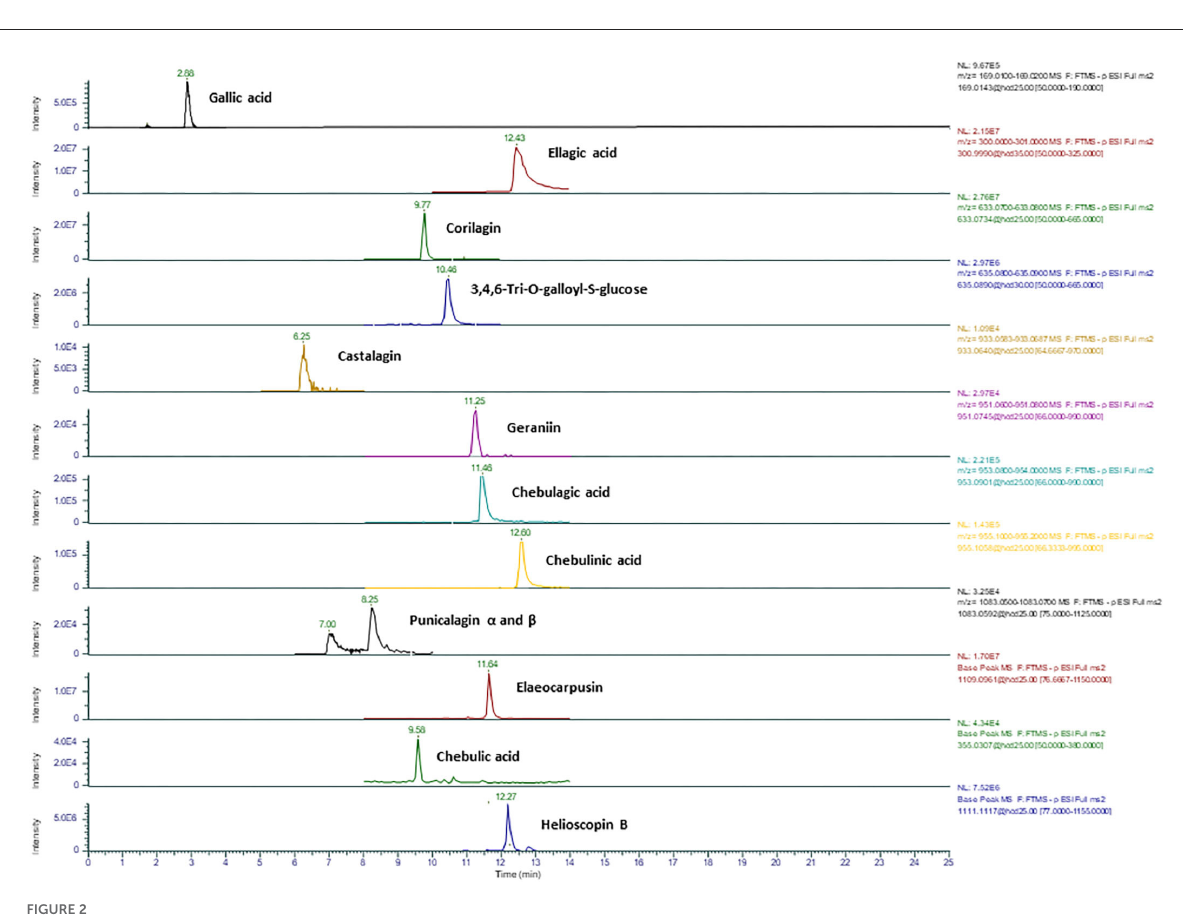
for Windows (Minitab Inc., State College, PA, USA). A p -value